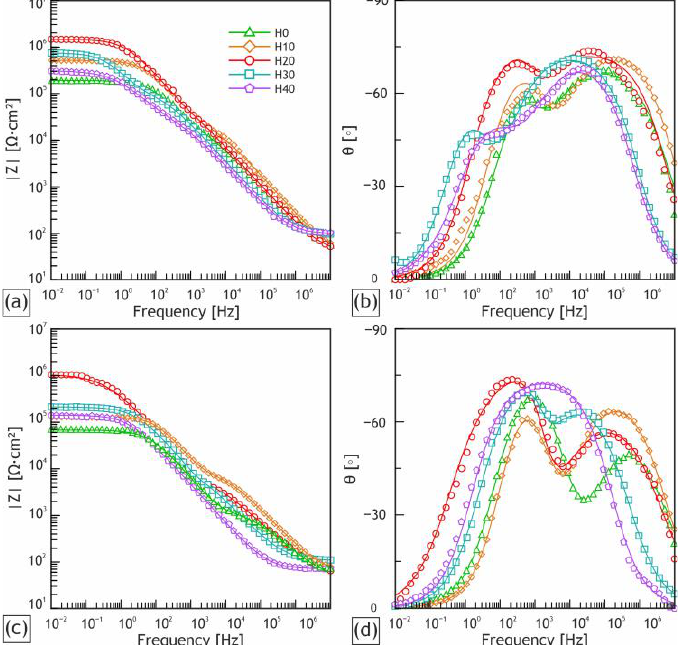
Figure 11. Bode plots (dependences of impedance modulus |Z| and phase angle θ on frequency for the obtained samples. Spectra were acquired after exposure to the corrosive medium for 2 h ( a , b ) and 24 h ( c , d ). Impedance spectra presented by experimental data (scatter plot) and fitting curves (solid lines).